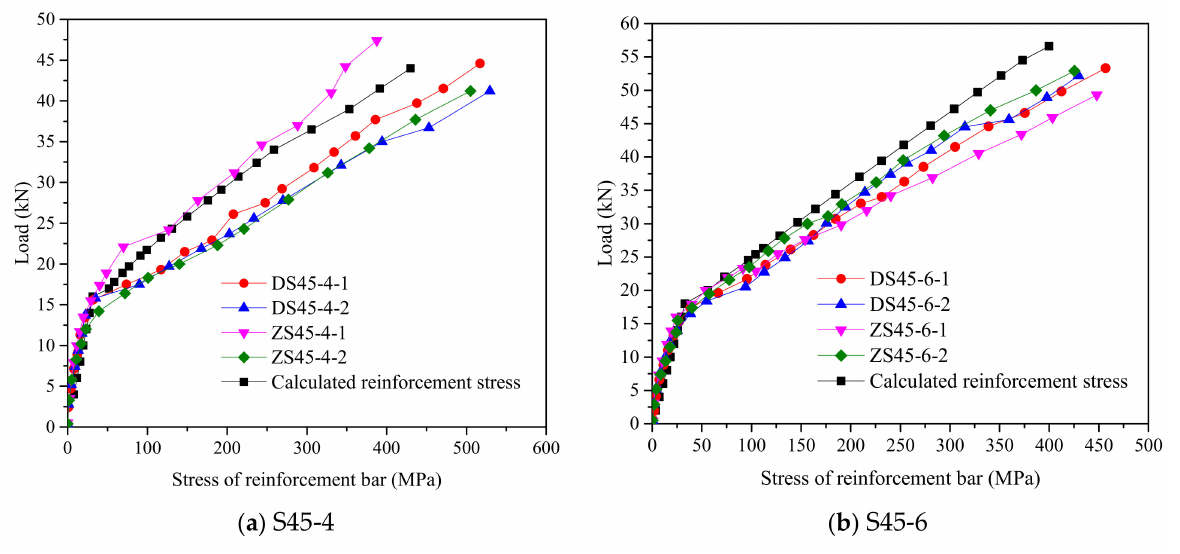
Figure 18. Load–Steel-Stress Curve of